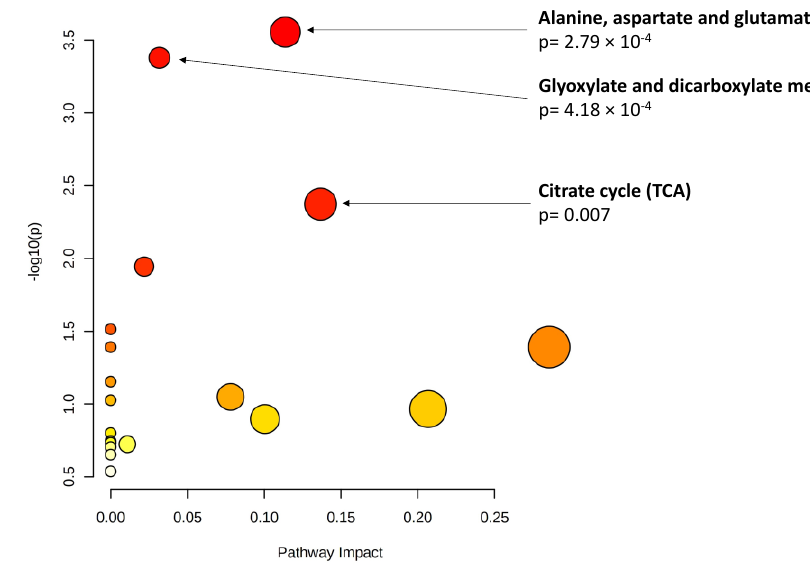
Figure 1. Pathway analysis of baseline metabolites associated with changes in area under the dark adaptation curve (AUDAC) at 3 years ( p < 0.01). X axis: pathway impact, calculated as the sum of the importance measures of the matched metabolites normalized by the sum of the importance measures of all metabolites in each pathway. Y axis: − log(p): logarithm of the p -value, based on the hypergeometric pathway enrichment test. The color and size of each circle are based on its p -value and pathway impact value, respectively. Namely, colors vary from white to red from less significant to most significant p -values.